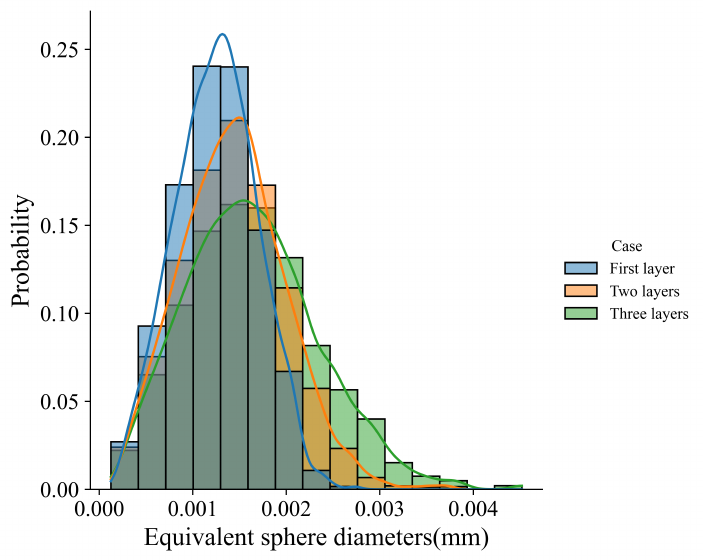
Figure 19. The grain size distribution of the simulation results in the first layer, the first two layers, and the three-layer